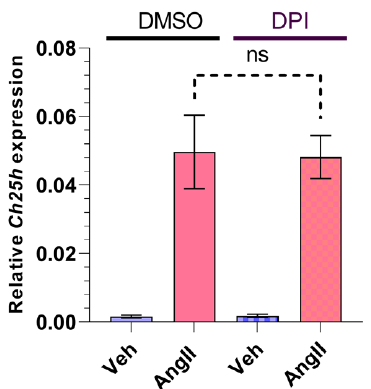
Figure 4. Effect of NOX inhibitor on Ch25h gene expression in rat VSMCs. Serum-deprived VSMCs were treated with 5 µ M DPI or DMSO for 30 min. Following treatment, VSMCs were stimulated with 100 nM AngII or vehicle (Veh) for 1 h. Ch25h mRNA levels are shown relative to Gapdh . Values are plotted as the mean ± SEM of n = 5 independent experiments. Data were analyzed using multiple linear regression, ns (not